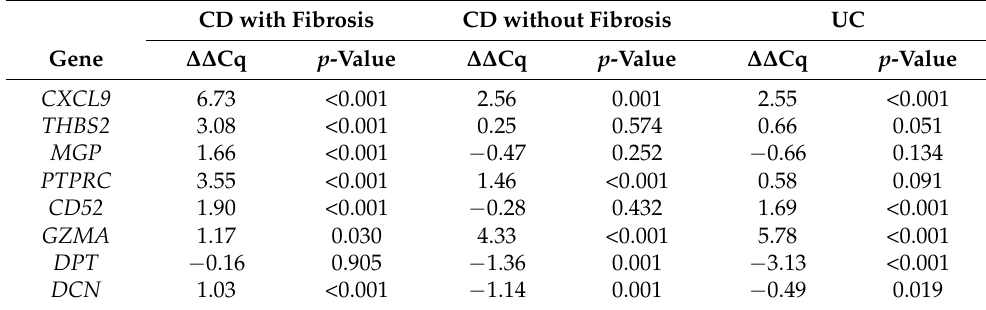
Table 4. Gene expression of CXCL9, THBS2, MGP, PTPRC, CD52, GZMA, DPT and DCN in colonic CD with fibrosis, colonic CD without fibrosis and UC expressed as ∆∆ Cq relative to normal colon. Legend: CD, Crohn’s disease; UC, ulcerative colitis.